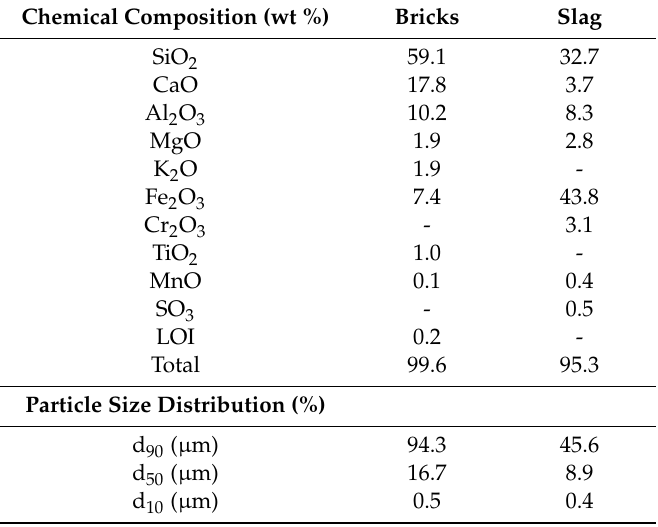
Table 1. Chemical analysis and particle size distribution of raw materials. Chemical Composition (wt %)